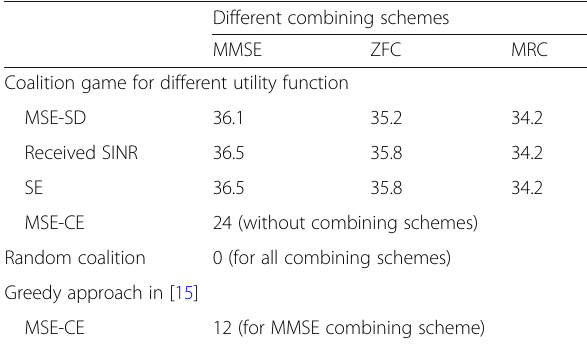
Table 3 The average number of searches ( α ) for different schemes Different combining schemes MMSE ZFC MRC Coalition game for different utility function